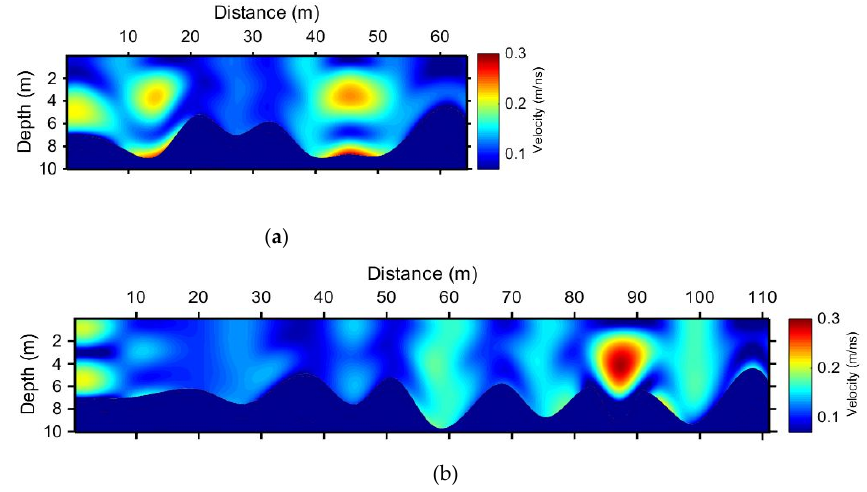
Figure 9. GPR depth velocity attribute based ( a ) on time-to-depth conversion of velocities in Figure 8b and ( b ) in Figure 8d. Dark blue values from around 6–9 m (laterally varying) down to 10 m denote no velocity data.